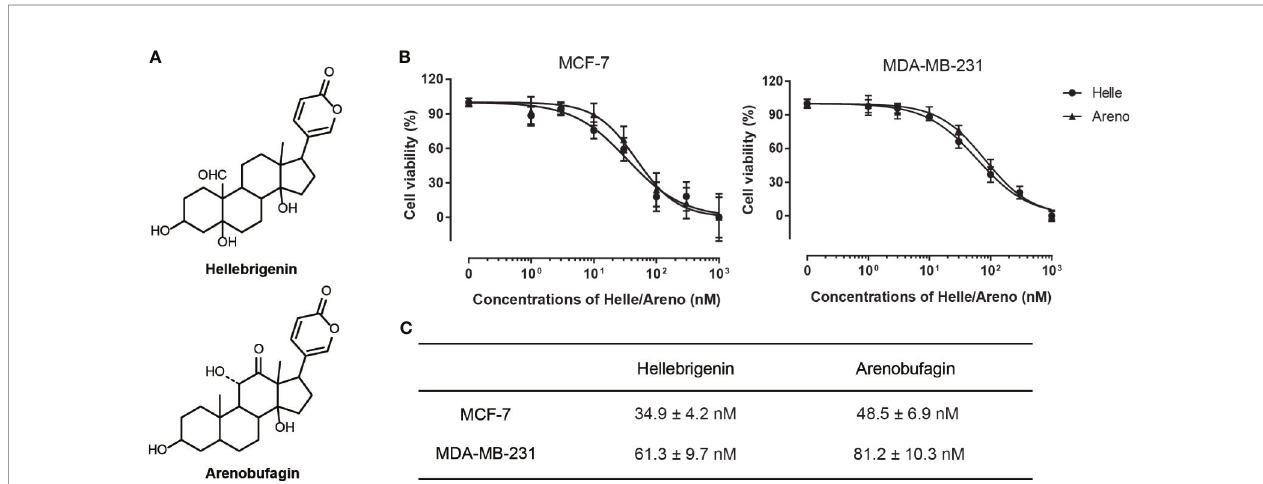
FIGURE 1 | Cytotoxic effects of Helle and Areno against human breast cancer cell lines MCF-7 and MDA-MB-231. Chemical structures of Helle and Areno (A) . Cell viability was determined by WST-1 assay after treatment of MCF-7 or MDA-MB-231 (B) with various concentrations of Helle and Areno (1, 3, 10, 30, 100, 300 and 1000 nM) for 48 h. Relative cell viability was calculated as the ratio of the absorbance at 450 nm of each treatment group against those of the corresponding untreated control group. The IC 50 values of the drugs were calculated using GraphPad Prism ® 7 software (C) . Data are shown as the means ± SD from more than three independent